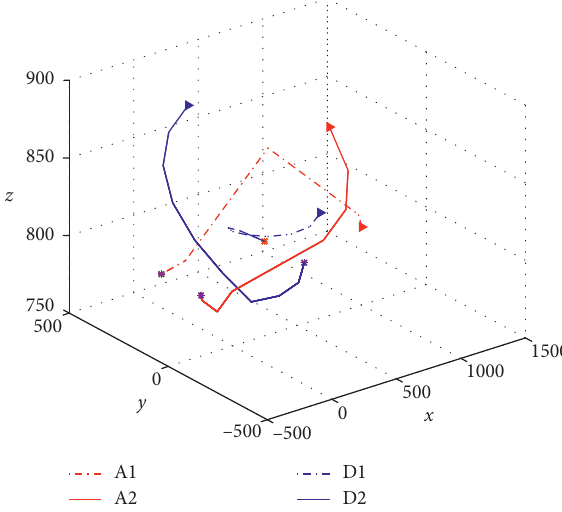
Figure 5: Multi-UUV cooperative dynamic maneuver decision-making: stage 2.